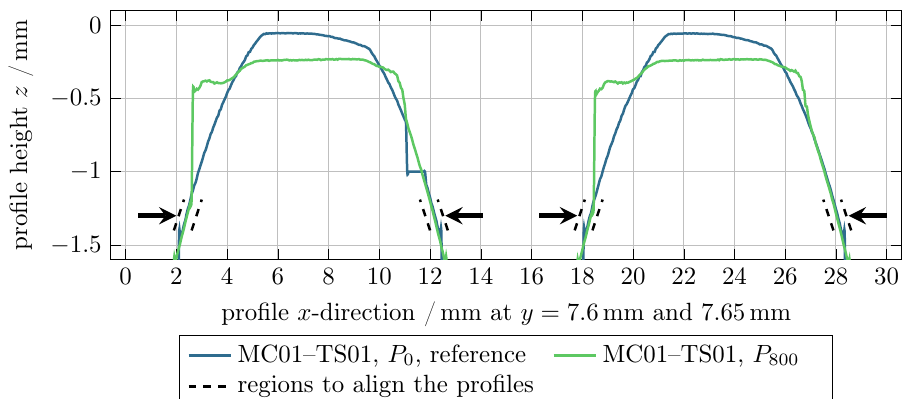
Figure 9. Exemplary comparison of selected profiles derived from topographical measurements of MC01–TS01 P i = 0 and P i = 800 with marked regions to align